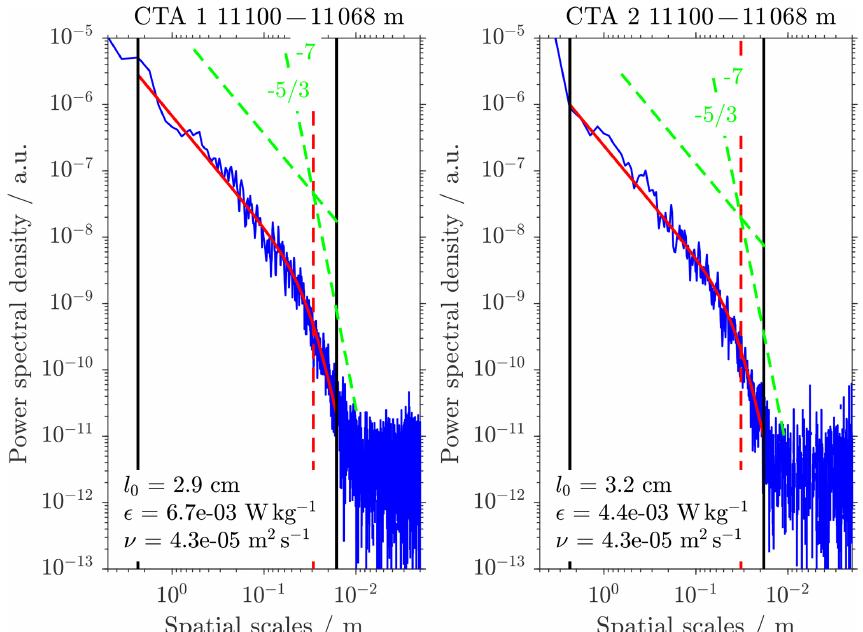
Figure 1. Power spectral densities of undisturbed atmospheric turbulent velocity fluctuations (dark blue). The spectra show data from two independent CTA measurements on the same gondola in the same 10s time span on a descending balloon (6 August 2016). The solid red curve gives the fit of Heisenberg’s turbulence model. The transition between the inertial ( − 5 / 3) and the viscous ( − 7) subrange is given by the vertical dashed red line (inner scale l 0 ). Vertical black lines show the fit range. Energy dissipation rates ε and kinematic viscosities ν are given in the lower left corner of each